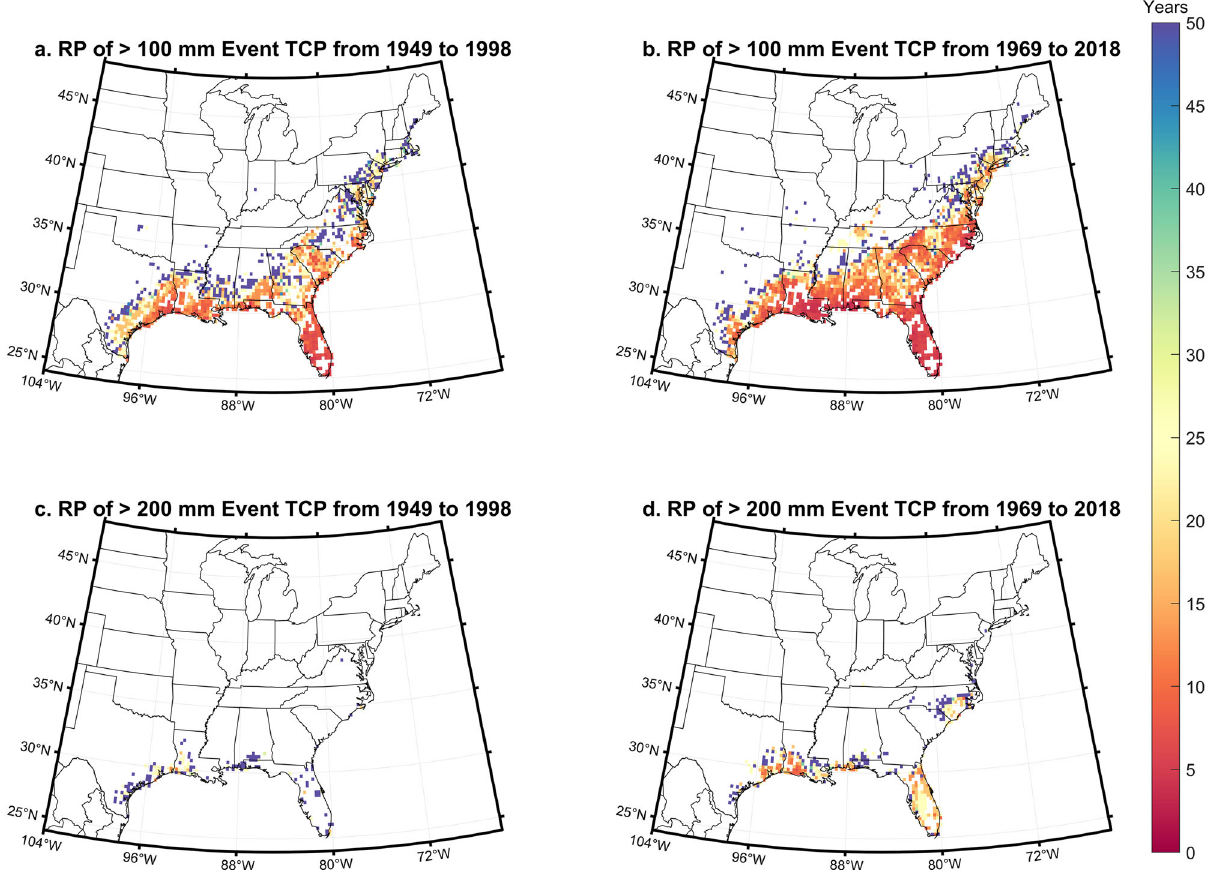
Fig. 2 Comparison of Return Period (RP, in years) for 100 and 200 mm Tropical Cyclone Precipitation (TCP) events between the early period (1949 – 1998) and the late period (1960 to 2018). Each panel is a RP for 100 mm TCP events in the early period, b RP for 100 mm TCP events in the late period, c RP for 200 mm TCP events in the early period and, d RP for 100 mm TCP events in the late period. Only locations with robust estimation of the empirical exceedance probability density curve are displayed.